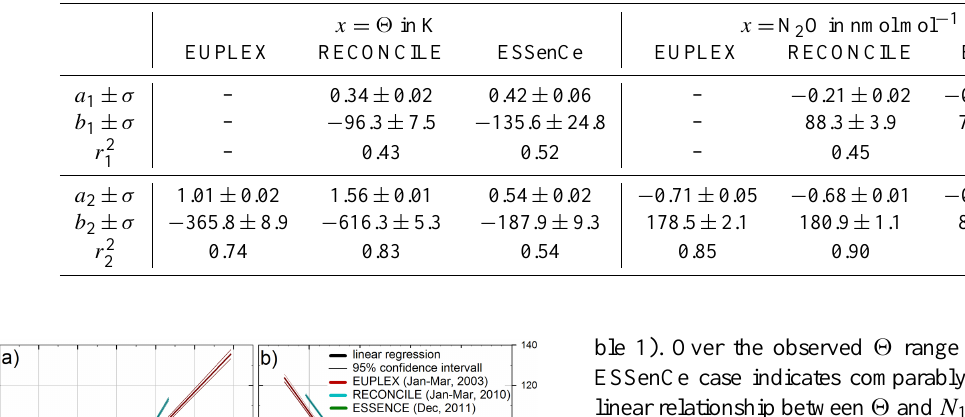
for 390K <(cid:50) ≤ 410K; a 2 , b 2 and correlation coefficient r 2 for (cid:50)> 410K. 1 2